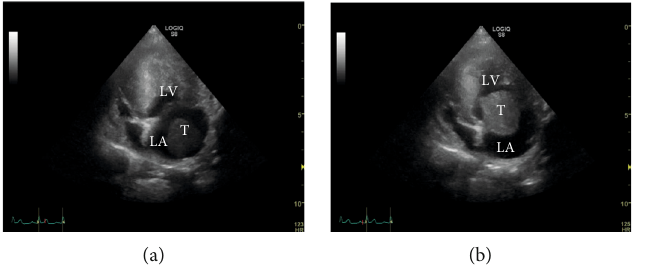
Figure 2: Transthoracic echocardiography (a). The thrombus in the left atrium shifts during diastole into the ostium of the mitral valve (b). T: thrombus; LA: left atrium; LV: left